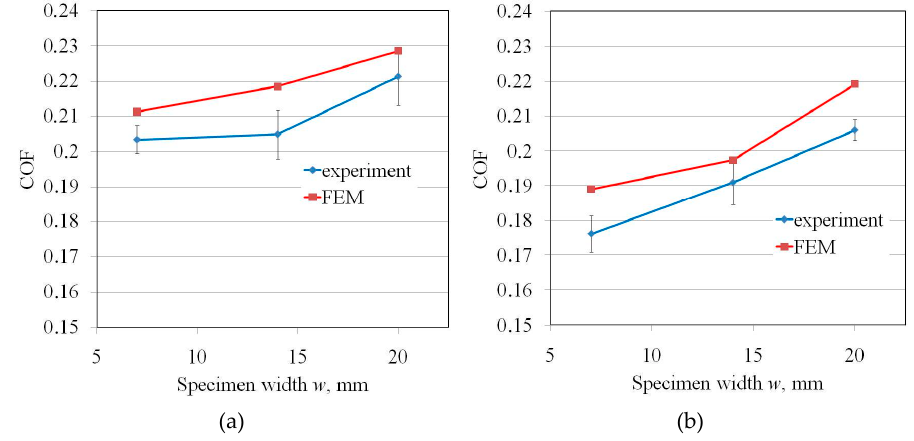
Figure 12. Comparison of average values of COF determined experimentally and based on FEM for drawbead heights of ( a ) h = 12 mm and ( b ) h = 18 mm.